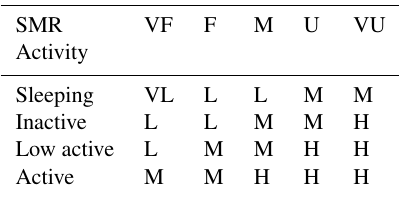
Table 6. Assessment of the predisposition to instability with the SMR